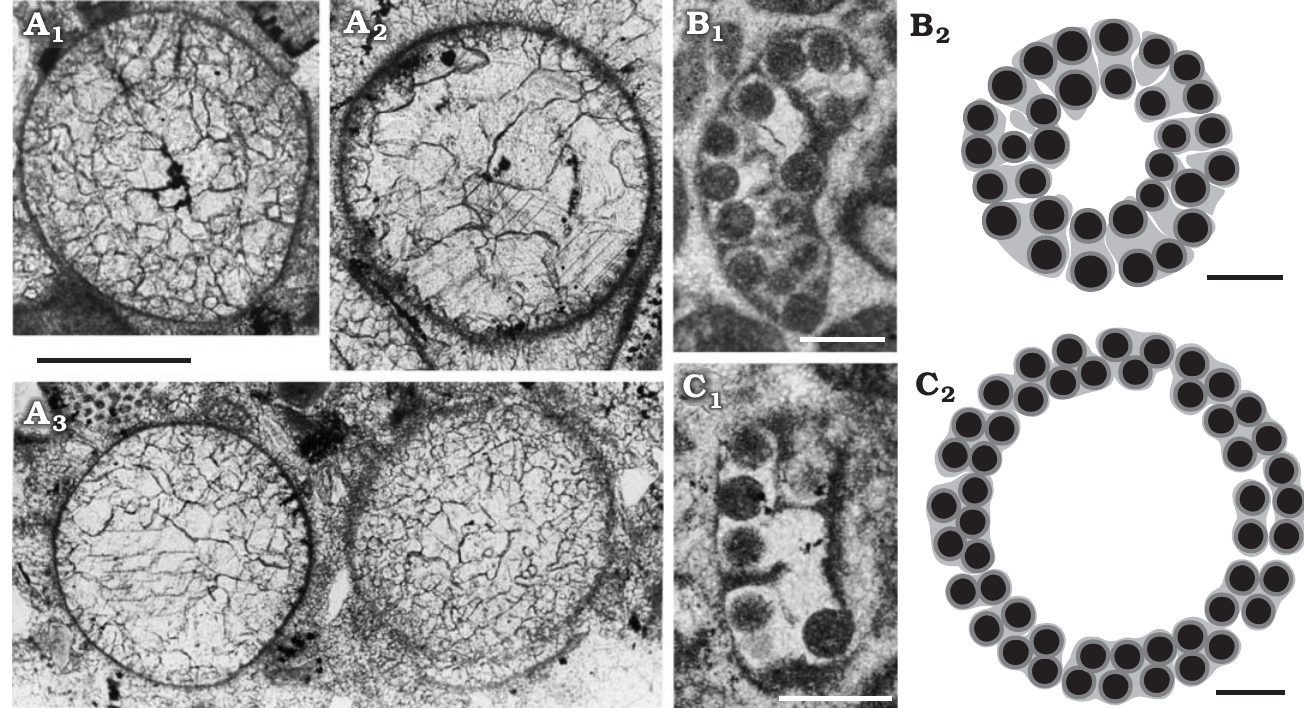
Fig. 12. Mineralized reproductive organs of dasycladalean alga Sedalanella segonzacae Elliott, 1986 from Palaeocene–lower Eocene, Sedalan (Kurdistan, Iraq) (A), and Ioanella lusitanica Granier and Berthou, 2002 from Ferreiras (Central Algarve, Portugal) (B, C). A . BM (NH) V. 41606, paratypes; A 1 , specimen displaying vestige of internal cavity (= Elliott 1986: fig. 1A, right specimen); A 2 , specimen with the internal cavity outline as in A, the micritic outer layer showing evidence of radial pores; A 3 , two specimens with different degrees of preservation, both show no trace of an internal cavity. B . LPB-29900(A)/B, holotype (1 st specimen in http://paleopolis.rediris.es/IFAA/jpg/Granier/Cluj_02_02.html). C . LPB-29900(A)/A (3 rd specimen in http://paleopolis.rediris.es/IFAA/jpg/Granier/Cluj_02_02.html). Photographs (B 1 , C 1 ), interpretative drawings (B 2 , C 2 ). Scale bars 200 μ